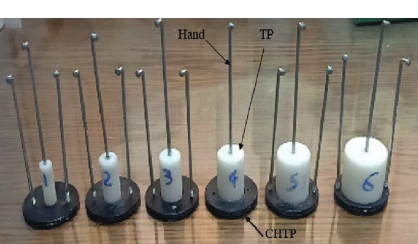
Figure 1: Teflon piles and circular hollow Teflon plates with steel